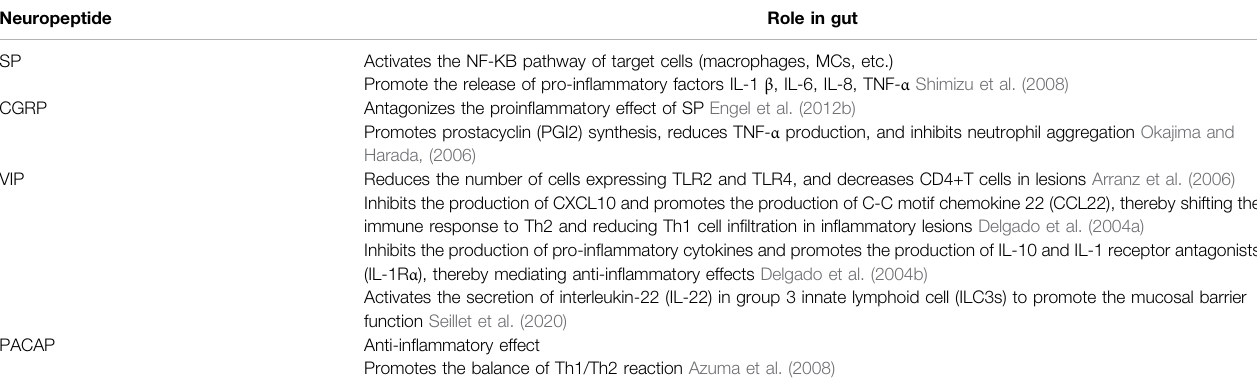
TABLE 4 | Regulation of intestinal neuropeptides on immunity. Neuropeptide Role in